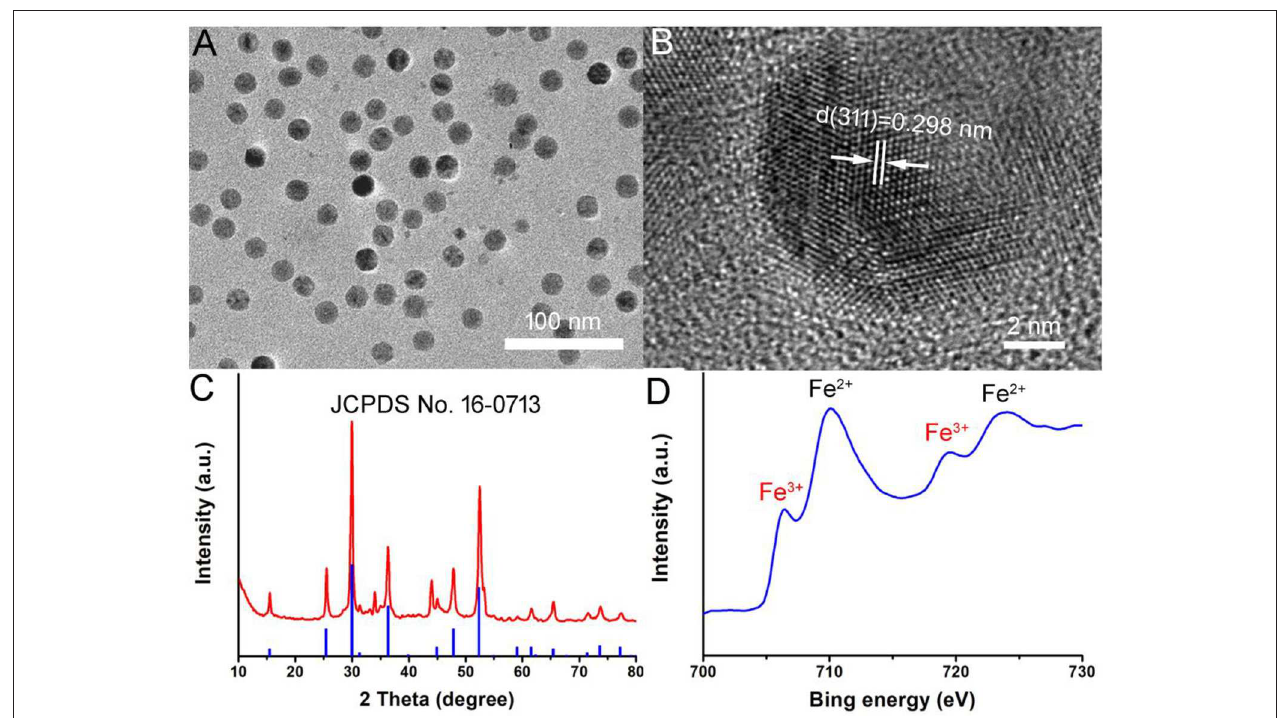
FIGURE 1 | (A) TEM image of as-prepared Fe 3 S 4 nanoparticles. (B) High resolution TEM image of Fe 3 S 4 nanoparticles. (C) XRD pattern of Fe 3 S 4 nanoparticles. (D) High resolution XPS spectra of Fe in Fe 3 S 4